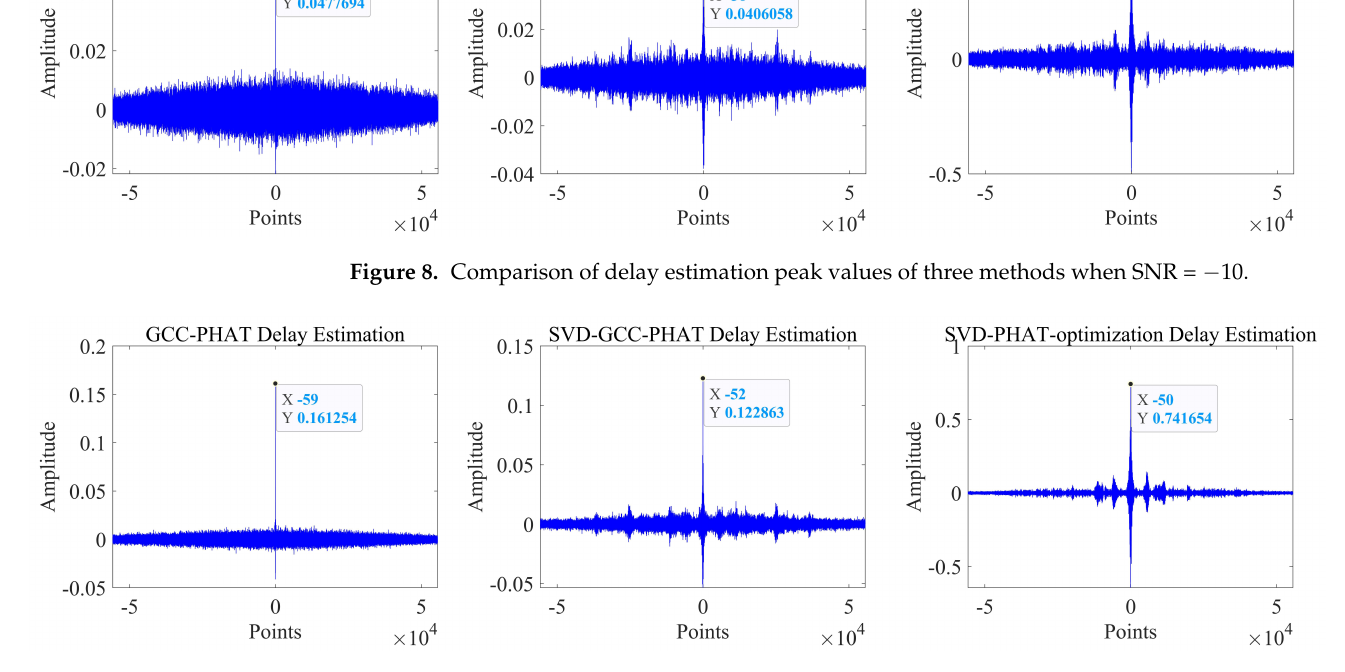
Figure 9. Comparison of delay estimation peak values of three methods when SNR = 0.